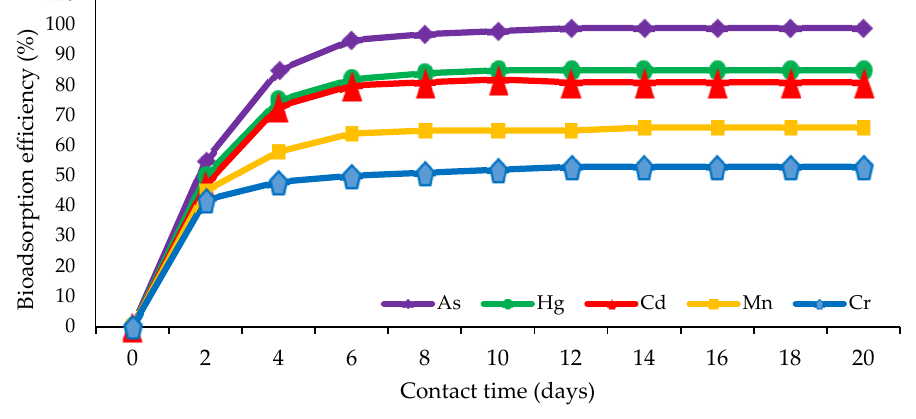
Figure 3. The pattern of adsorption of sponge symbiont bacteria on some heavy metal pollutants. This phenomenon indicates that the adsorption model involves an extracellular ionic bond between the positive pole of the heavy metals and the negative pole of the bacteria on the surface, such that adsorption can occur very quickly when the negative surface of the bacteria is active [60,65,132,134]. The contact duration of 6 days is considered the general period required for the fishery to reach the saturation stage, whereat most of the negative poles of the bacterial surface will have formed ionic bonds with heavy metal ions [35,124]. Under these conditions, the bacterial cells can no longer continue their adsorption activity, and the process towards the division phase and cell growth is declared to have stopped [28,107].